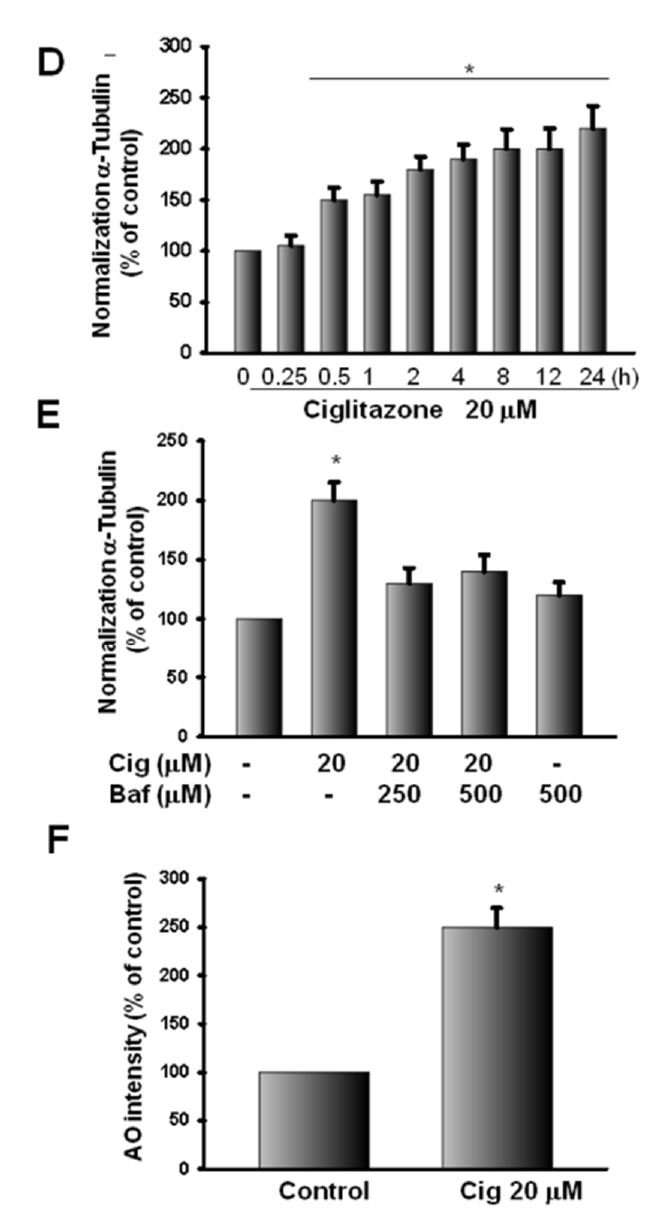
Figure 8. Induction of autophagy marker LC3 and acidic vesicular organelles (AVOs) by ciglitazone in U87 glioma cells. ( A ) U87 were treated with ciglitazone in a time-dependent course and analyzed in LC3 expression by Western blotting. ( B ) The induction of LC3 was affected by bafilomycin. ( C ) The staining AVOs by acridine orange stain were shown in the different treatment group under 400 × magnification. ( D ) The relative quantification of LC3 I/II induced by ciglitazone related to different time profile was determined in Western blot analysis. The data showed the expression in a time- dependent course. ( E ) The quantitative analysis of LC3I/II protein expression in U 87 cells pretreated with Baf, following ciglitazone exposure. ( F ) Quantification of AO intensity (% of control) in U87 cells treated with 20 µ M of ciglitazone. The results revealed the statistically different increase in AO expression after ciglitazone treatment. Data are expressed as mean ± SD ( n = 6). * p < 0.05: as compared with control. The α -tubulin was loaded as a